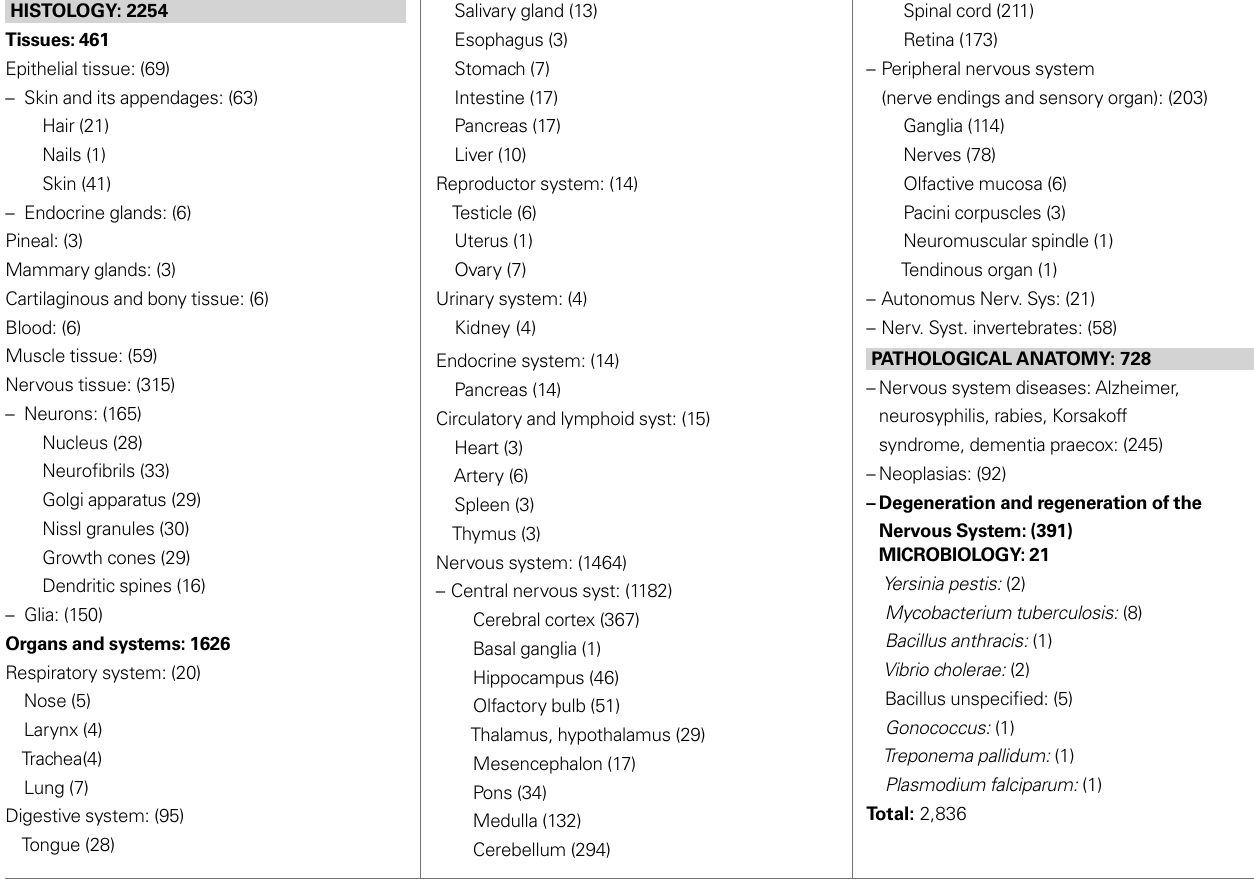
Table 1 | Classifi cation of the histological slides according to the biological